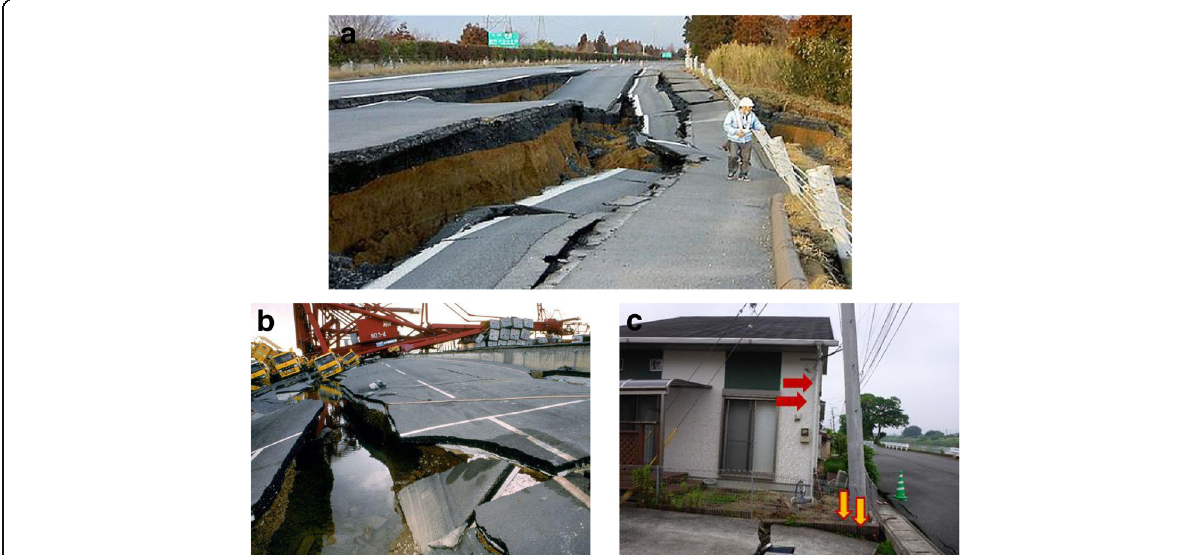
Fig. 1 a Damaged road due to liquefaction in the Great East Japan earthquake. b Damaged road due to liquefaction in the Great Hanshin earthquake, Japan. c Tilted house due to liquefaction in the 2016 Kumamoto earthquake,